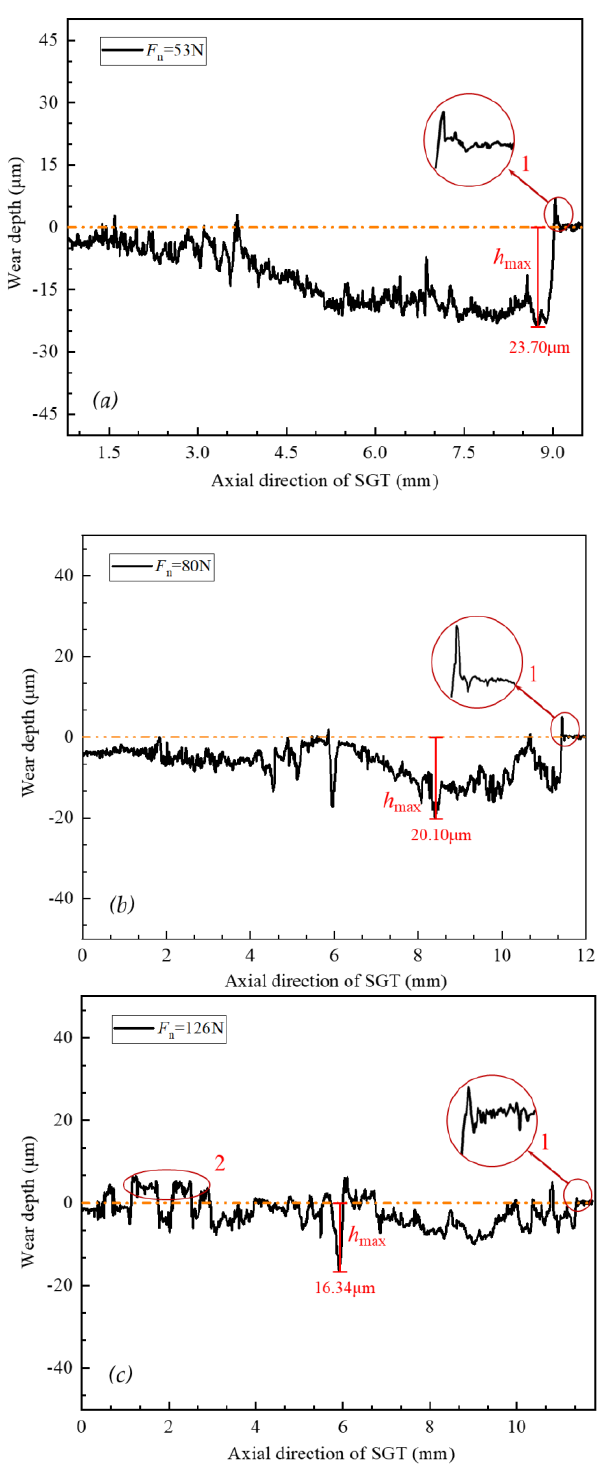
Figure 11. 3D morphology of wear scar and worn surface under operating conditions: ( a ) clamping force of 53 N; ( b ) clamping force of 80 N; ( c ) clamping force of 126 N.